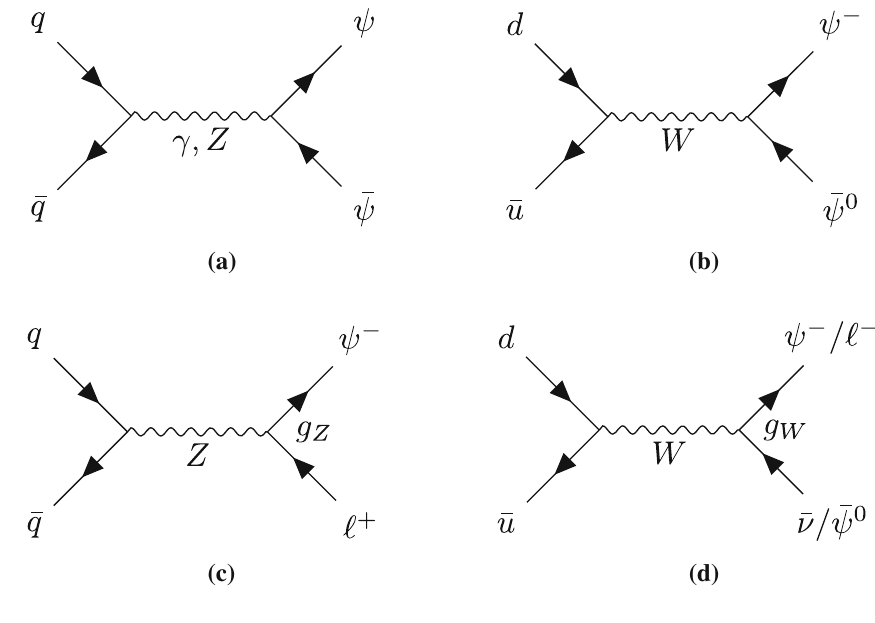
(diagrams a and b ) and single (diagrams c and d ) production channels of vector-like leptons at pp colliders. Diagrams c and d involve the couplings g Z and g W , which are induced by fermion mixing and κ (2),